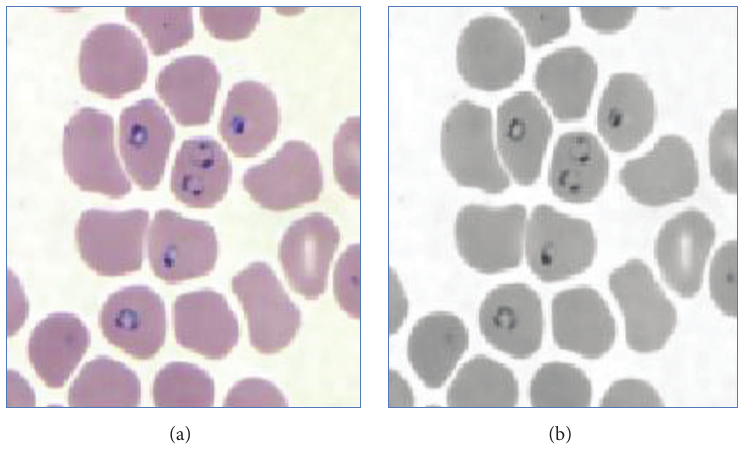
Figure 3: RGB image to gray scale image. (a) RGB image. (b) Gray image.